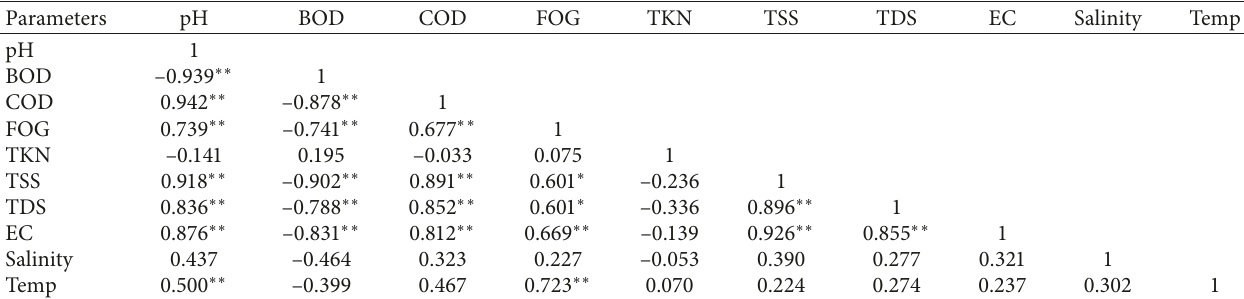
Table 6: Correlation coefficients of various pollutants from nonaeration HSFCWs.